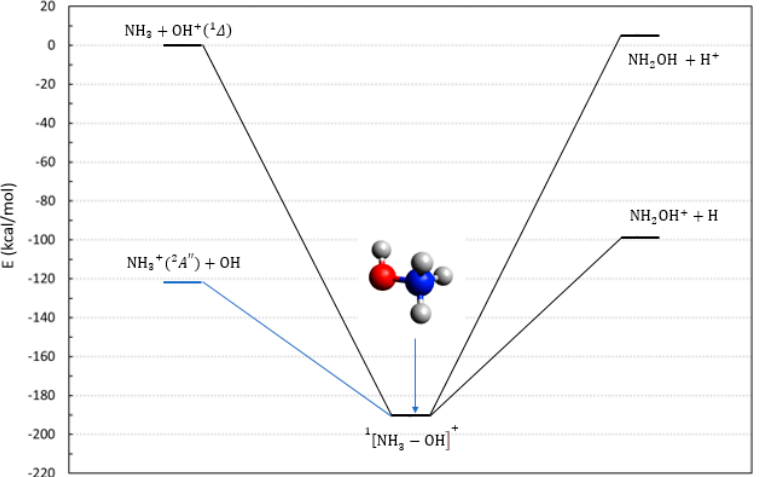
Figure 1. Energetic scheme of the possible entrance and exit channels of reactions 1 and 2 , involving the system [OH–NH 3 ] + in its singlet multiplicity. Energies computed at CCSD(T)/Def2-TZVPP level. By looking at Figure 1, one can see that both routes to hydroxylamine (neutral and cation), starting with cationic NH + (in blue in Figure 1) and passing through a singlet PES, are endothermic.